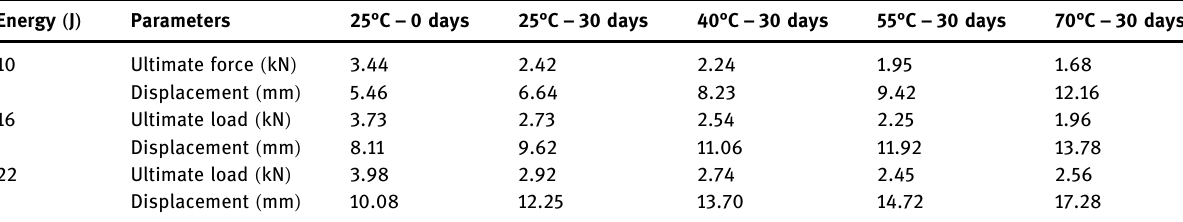
Table 2: Impact mechanical parameters for sandwich panels with and without hydrothermal aging Energy ( J